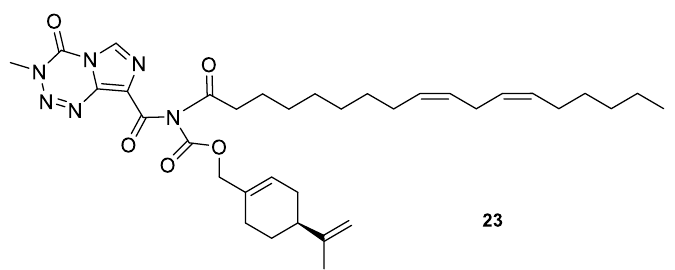
Figure 11. Chemical structure of NEO412 drug.